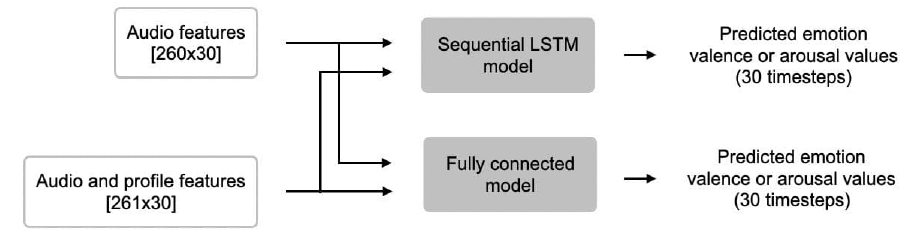
Figure 5. Overview of the two proposed models and their